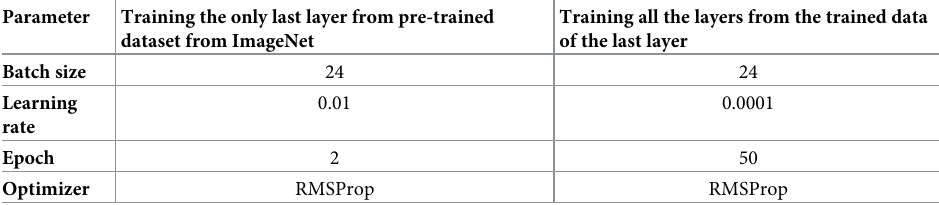
Table 1. Hyperparameters for the training of the AI. Parameter Training the only last layer from pre-trained dataset from ImageNet